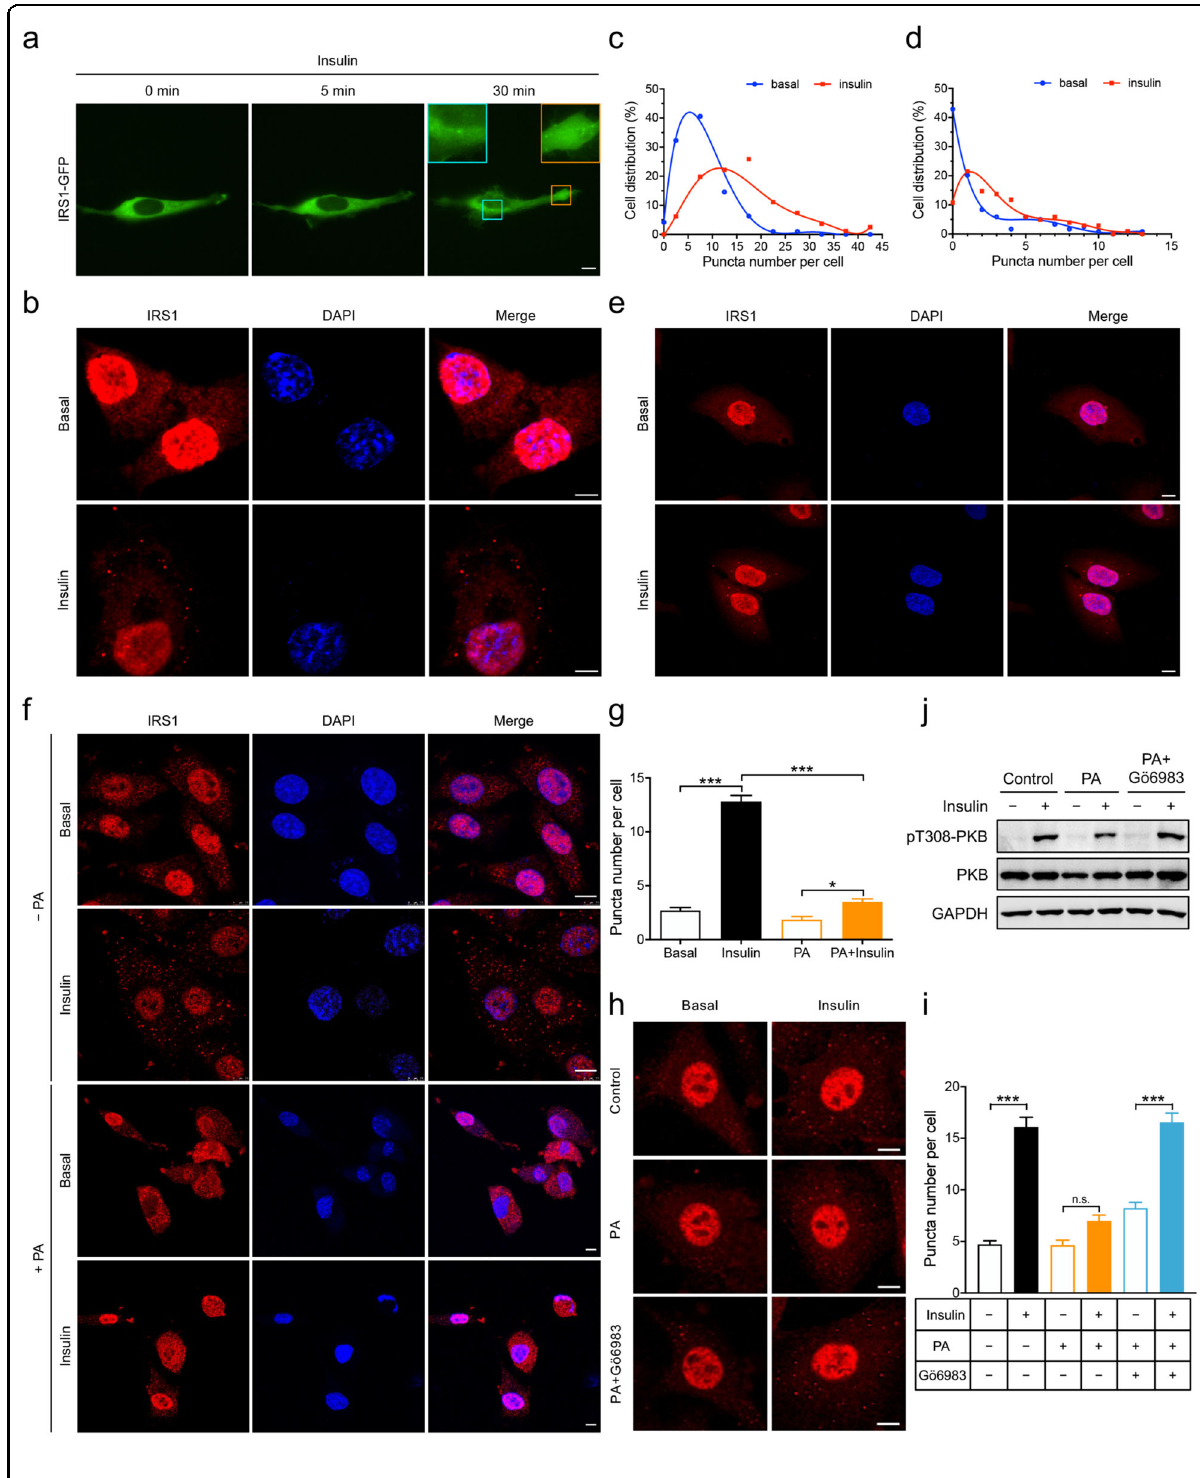
Fig. 4 (See legend on next